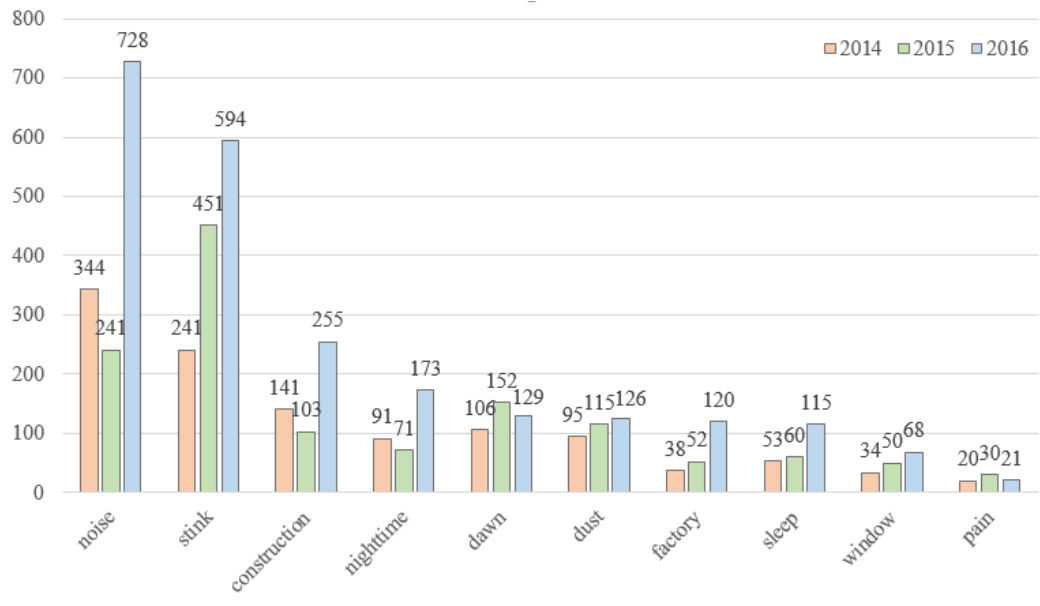
Figure 7. The frequency of words that have been appearing for three years. F igure 7. The frequency of words that have been appearing for three years.